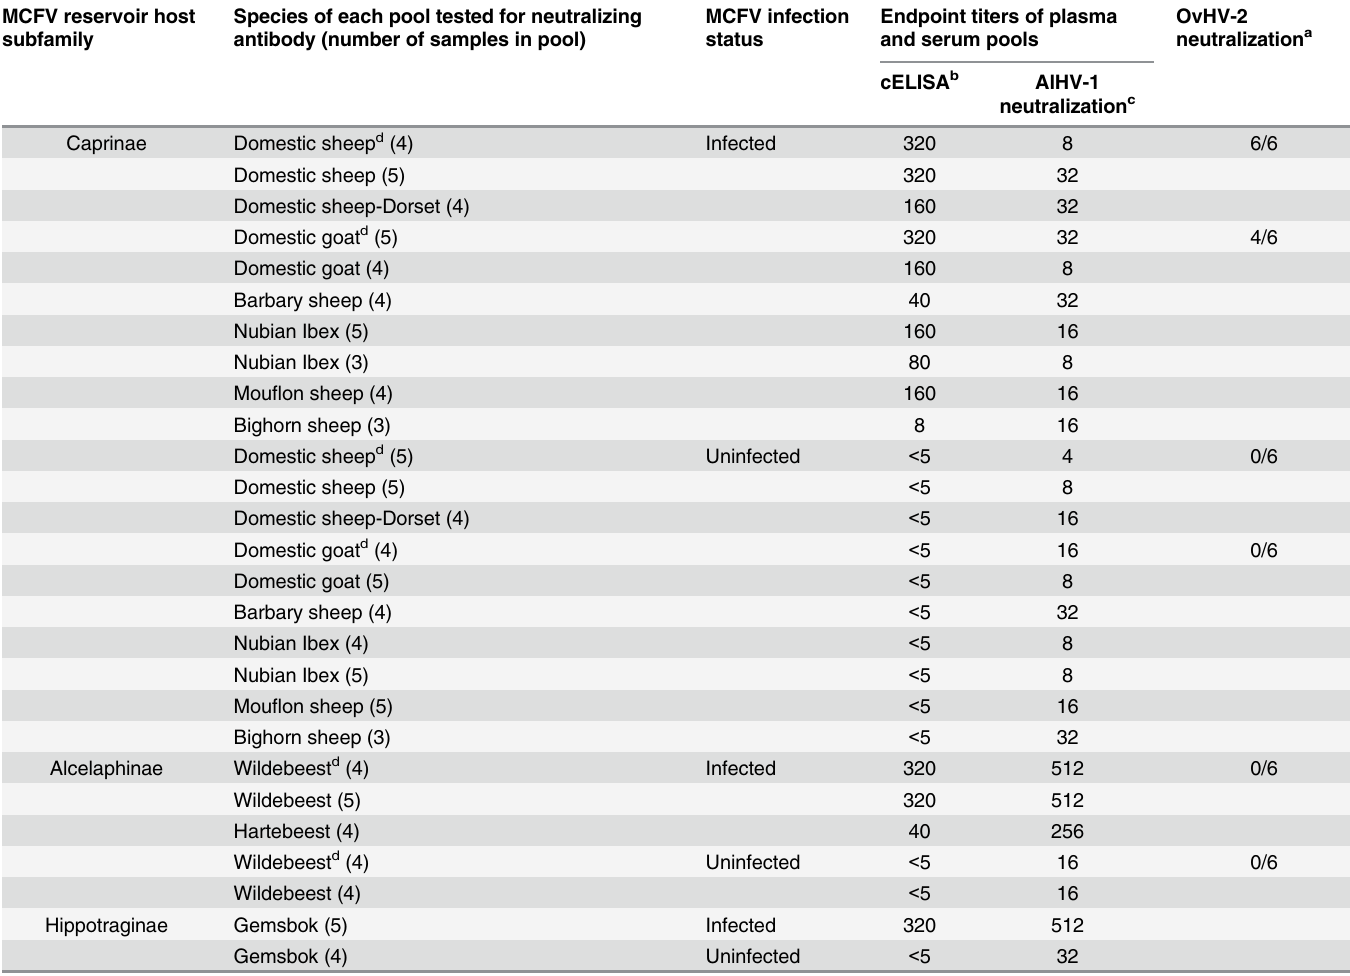
Table 1. Pooled serum and plasma samples used for virus neutralization assays. MCFV reservoir host Species of each pool tested for neutralizing subfamily antibody (number of samples in